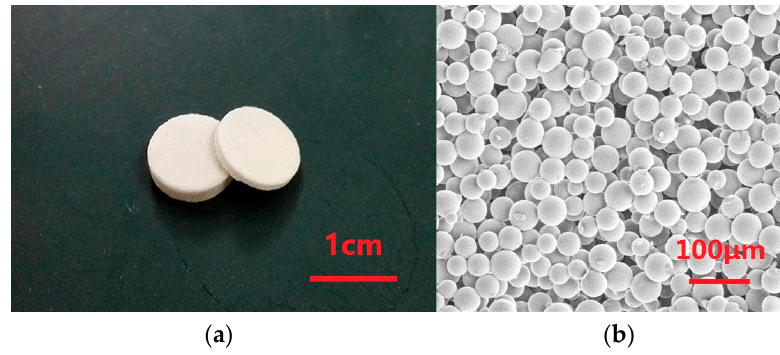
Figure 2. Transducers and the microstructure. ( a ) Appearance of the transducers; ( b ) microstructure of the transducer of Type 1. Table 1. Parameters of the glass microspheres and mixture types.